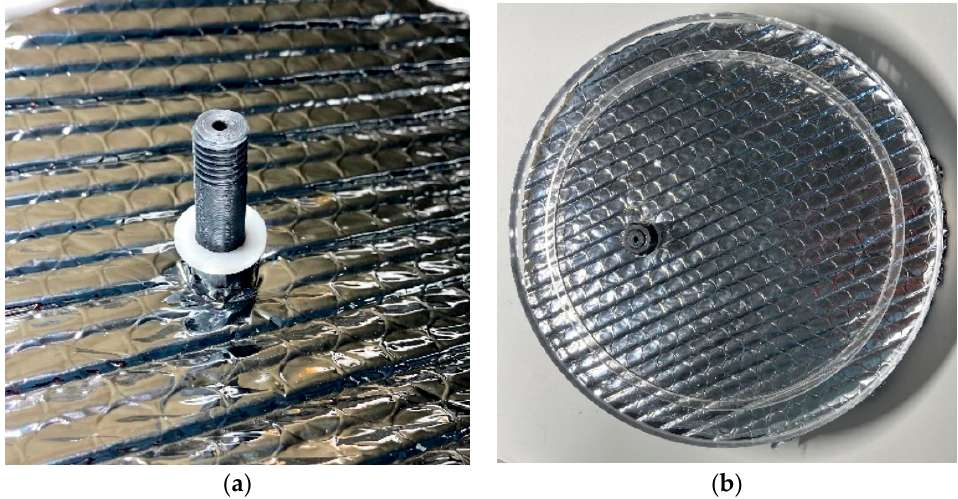
Figure 5. Process to connect the air ejector to the lid. Note that the photographed part is grey here, where it was orange in prior photos. ( a ) Feeding the vacuum connector through the insulation, then an M10 washer (nylon or rubber); ( b ) feeding the vacuum connector through the lid, then another washer, then secure with an M10 nut.